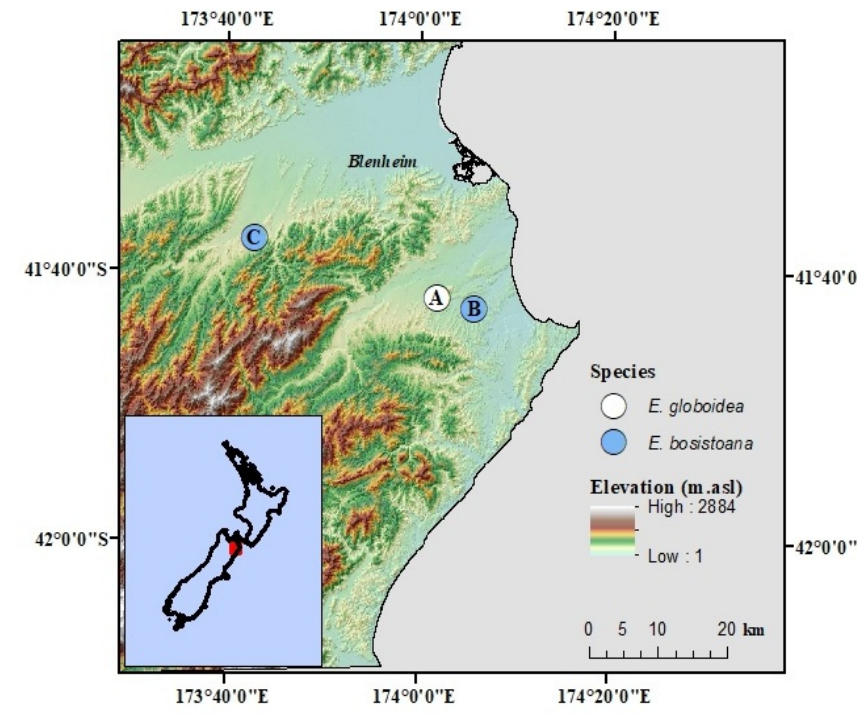
Figure 1. Study site locations. Table 1. Summary of the experimental site inventory data.